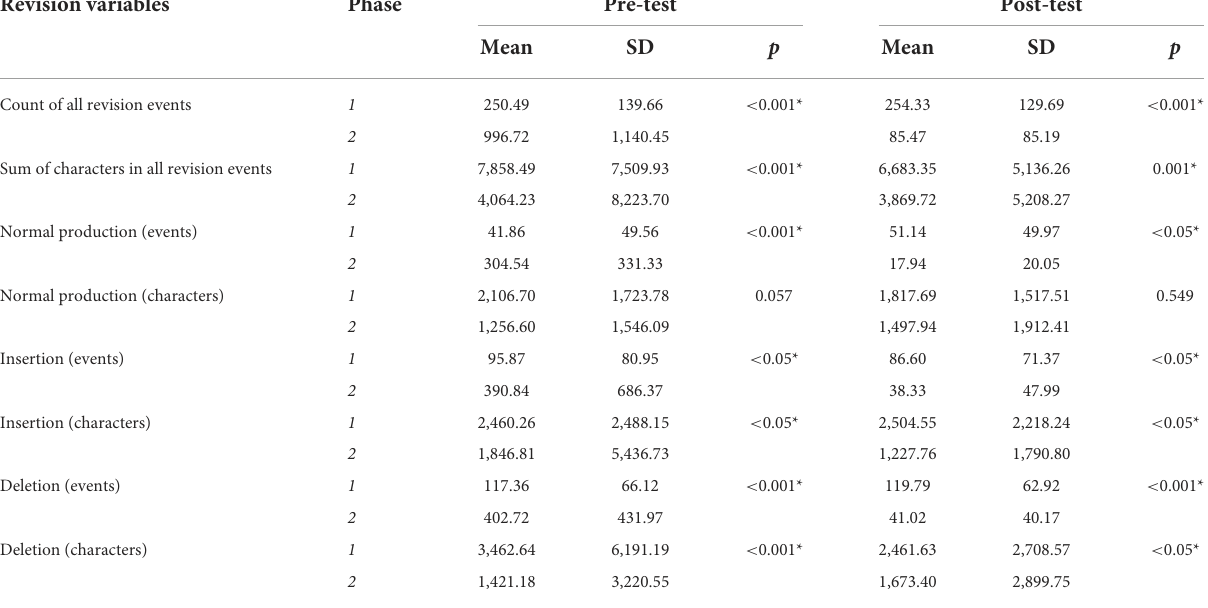
TABLE 2 Revision behavior across writing